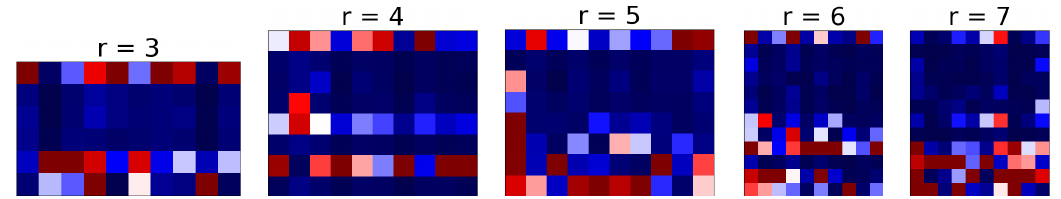
Figure 3 . Each grid shows the LRP results for 10 neural network inputs. The grid labels r ∈ [3 , 7] determine the form of the input vector. Each column represents a single input, corresponding to the real and imaginary parts of the knot’s Jones polynomial evaluated at the phases e 2 πip/ ( r +2) with p ∈ Z and 0 ≤ 2 p ≤ r + 2 . Dark blue squares correspond to the smallest magnitude for the relevance score, and red to the highest. So, in a given column, the red squares represent evaluations which were highly relevant for the neural network to predict that knot’s volume. We also see that the same evaluations are often relevant across all 10 knots in the displayed set; these correspond to mostly red